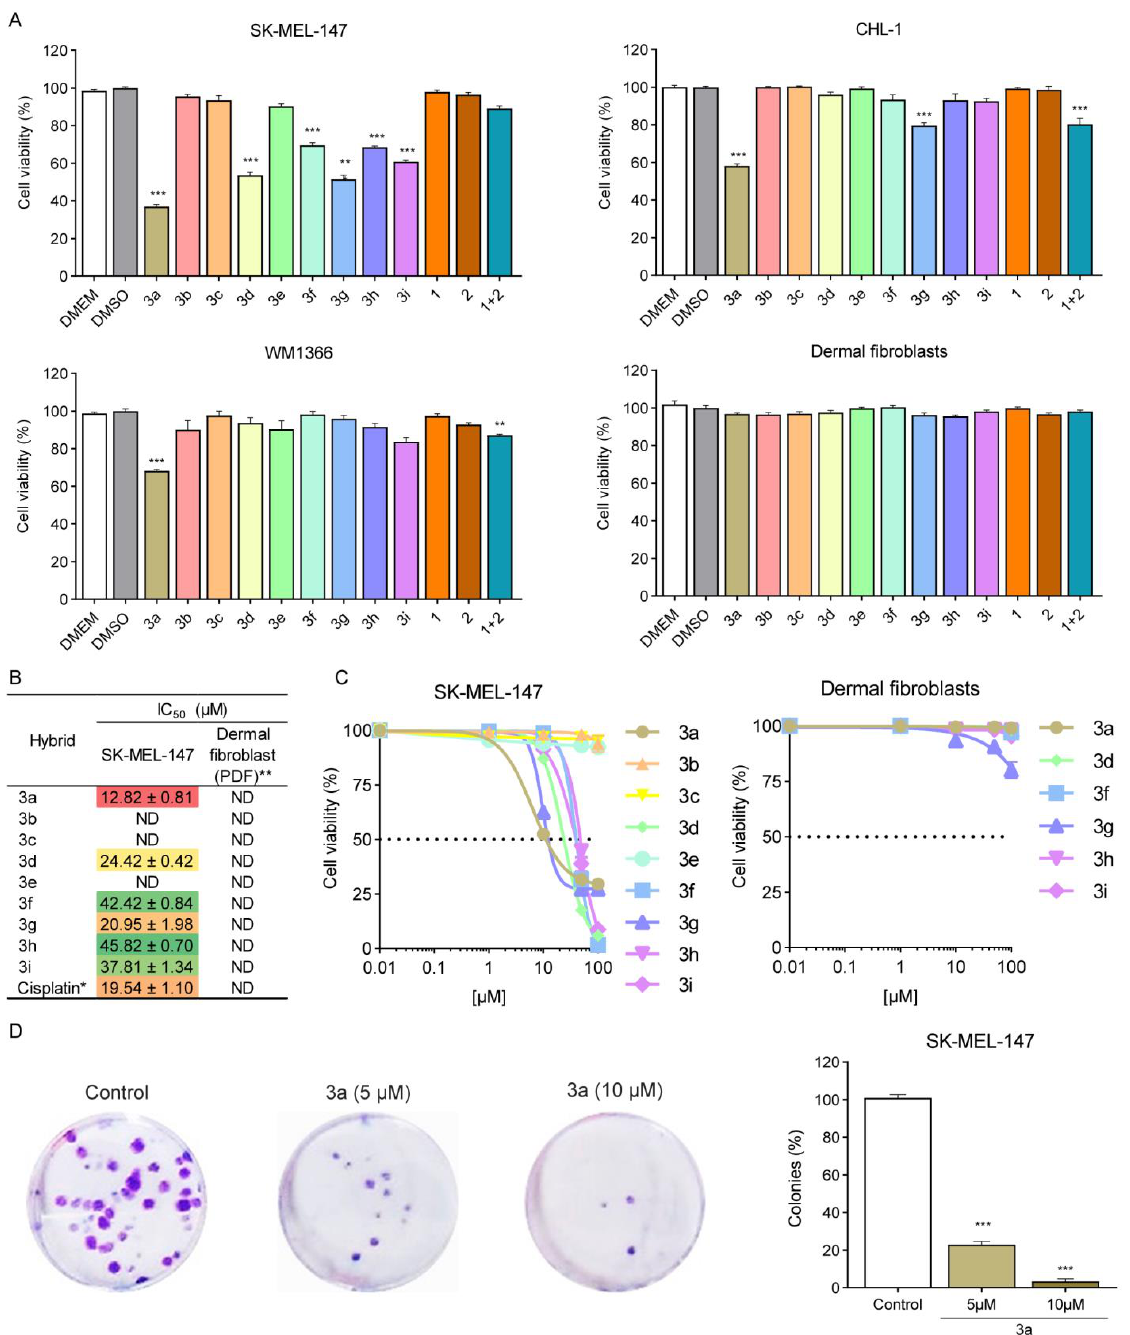
Figure 2. Compound 3a is cytotoxic to melanoma cells but not to primary dermal fibroblast. ( A ) Cell viability was determined by sulforhodamine B (SRB) after 48 h of treatment with the different compounds. DMSO (0.1% v / v ) was used as negative control; 1 , piperine; 2 , chlorogenic acid. ( B ) IC 50 values ( µ M) determined by SRB. Cell cultures were treated with substances 3a–i for 48 h. * Cisplatin was used as a positive control. ** non-tumor cell line (primary dermal fibroblast). ND: not determined once cell viability was not sufficiently reduced to determine IC 50 values. ( C ) Growth curves determined by SRB after 48 h of treatment with target-compounds in SK-MEL-147 cells and dermal fibroblast cell cultures. ( D ) Clonogenic assay of SK-MEL-147 cells treated with 3a at 5 or 10 µ M for 24 h and recovered in fresh medium for additional 12 days. ** p < 0.01 and *** p < 0.001 compared to DMSO according to ANOVA followed by Dunnet post-test. DMSO: Dimethylsulfoxide; DMEM: Dulbecco’s Modified Eagle